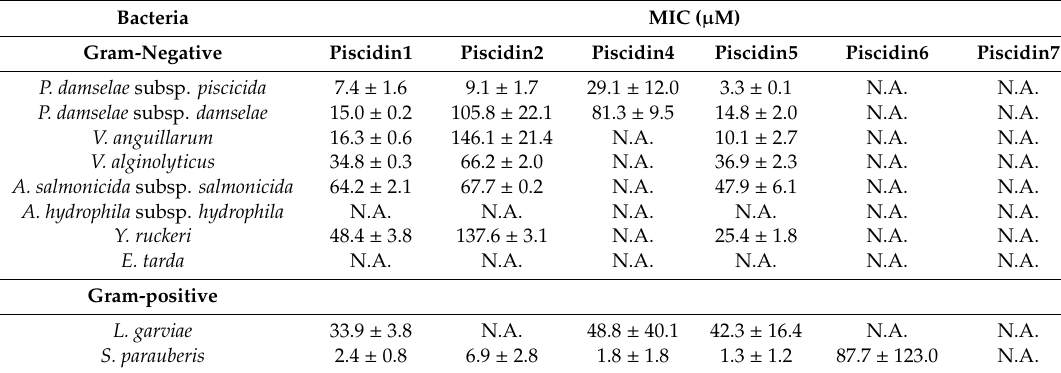
Table 3. Antibacterial activity of sea bass synthetic piscidins.